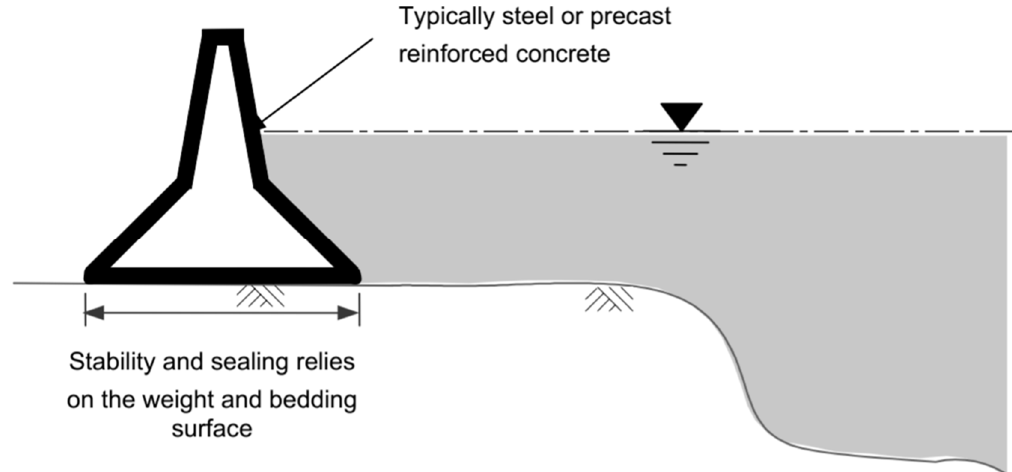
Figure A3. Frame barrier, derived from Ogunyoye et al. [19].